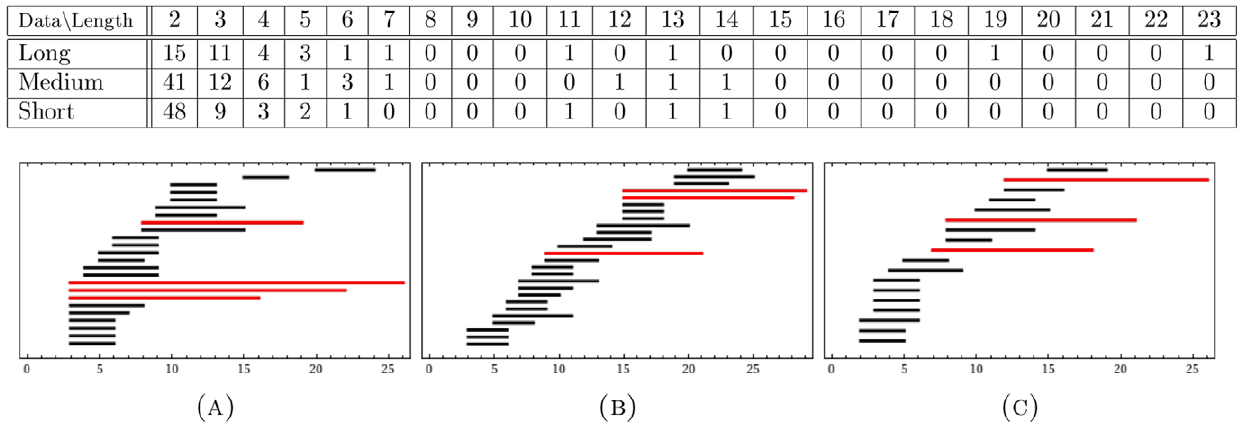
Figure 4. b 1 -persistence intervals (only lifespans w 2 are shown) for the reduced proximal (A) long; (B) medium; and (C) short data